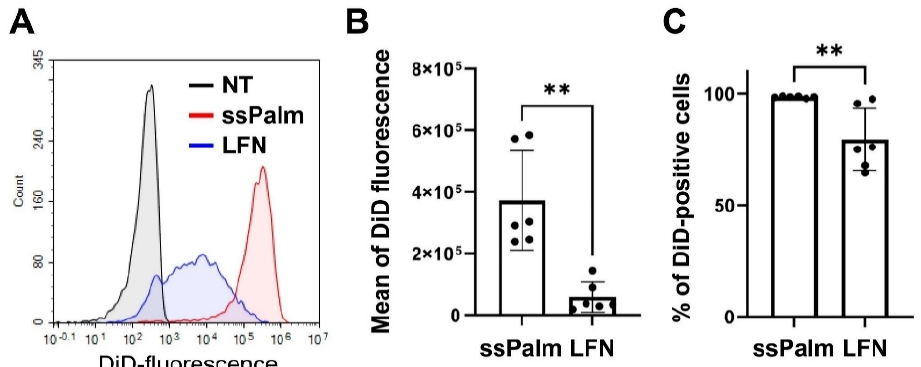
Figure 3. Cellular uptake of the ssPalm LNP or LFN. The cellular uptake of the ssPalm-LNP and LFN by hCMEC/D3 cells was measured by flow cytometry. ( A ) Representative histogram of the uptake of DiD-labeled ssPalm-LNP and LFN by hCMEC/D3 cells at a concentration of 0.4 μg/mL. Black, blue, and red lines indicate the non-treated (NT), the LFN-treated, and the ssPalm-LNP- treated group, respectively. ( B , C ) The mean of DiD fluorescence intensity ( B ) and the percentage of